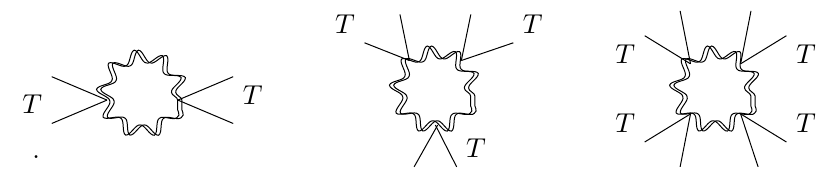
Figure 2 . Schematic of UV divergent matter terms at one loop where T stands for the stress energy tensor so schematically T (cid:24) (cid:30) 2 + 2 + F 2 .